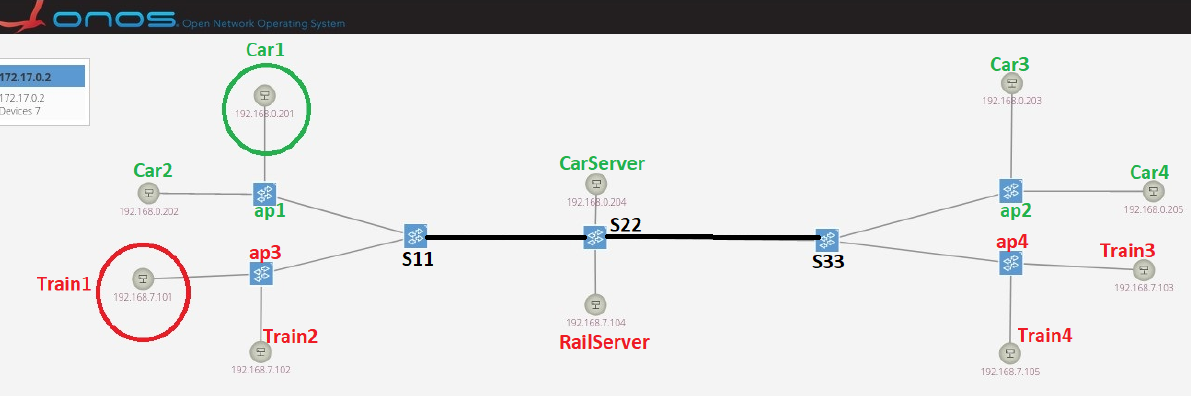
Figure 5. S2(5/6)1: Different Access Network and Shared Core, Track Parallel to Road Topology: ONOS